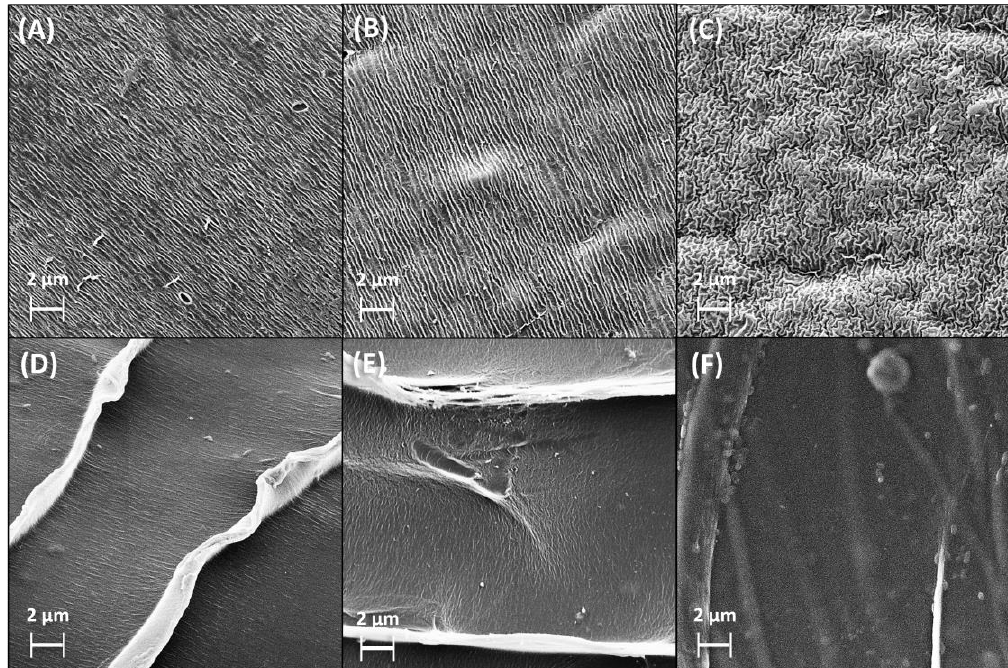
Figure 1. SEM images for lyophilized spheres of ( A ) AlgGel, ( B ) AlgGel + Cu(II), ( C ) (Cu(II) + His) + AlgGel, ( D ) AlgCol, ( E ) AlgCol + Cu(II), and ( F ) (Cu(II) + His) + AlgCol.